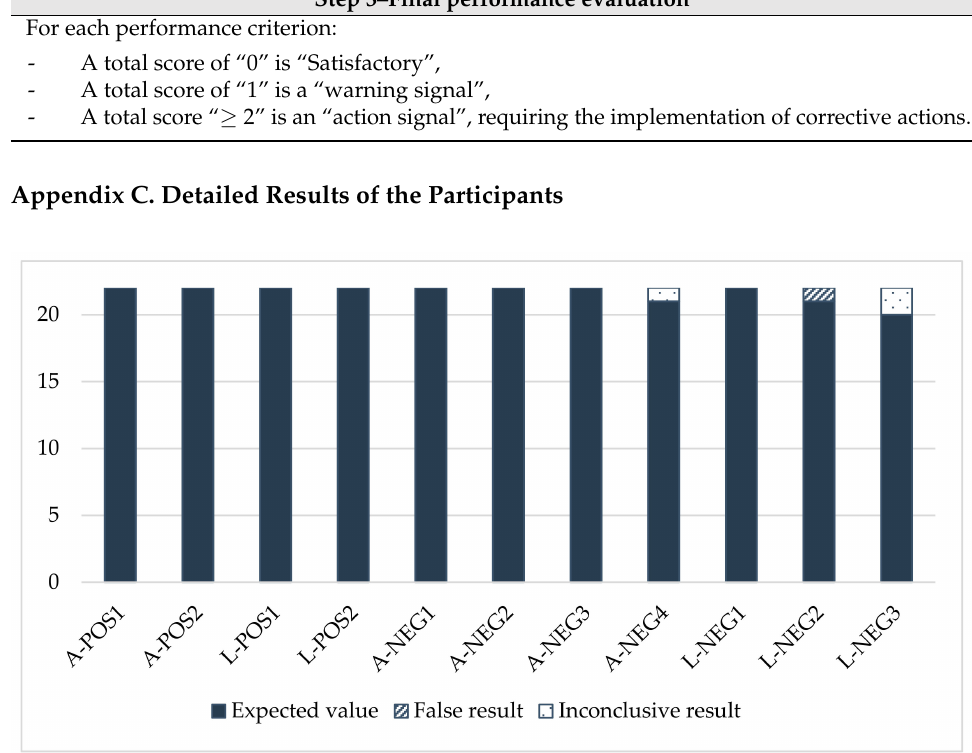
Figure A1. Consistency of the morphology